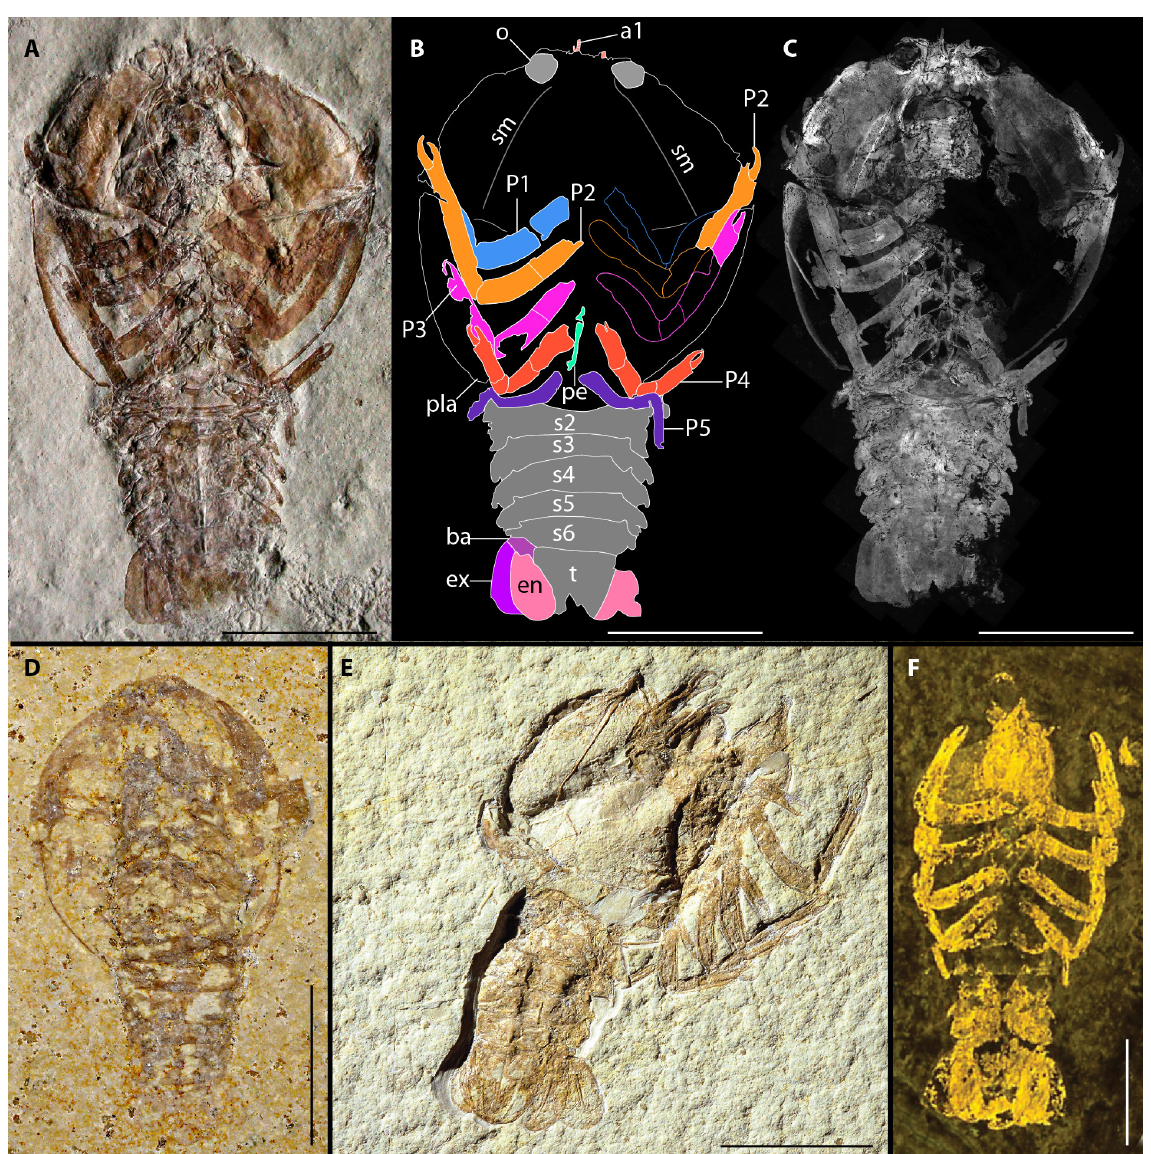
Fig. 5. Rogeryon oppeli (Woodward, 1866) gen. et comb. nov. from the Upper Jurassic (Tithonian) of Germany. A–C . Specimen SMNS 66004 (Sappenfeld), dorsal view, natural light (A), interpretative line- drawing (P1-P3 on one side were restored and are therefore drawn as outline (B) and green fluorescence (C). D . Specimen SMNS 65545 (Eichstätt), ventral view, natural light. E . Specimen SMNS 66004/2 (Langenaltheim), ventral view, natural light. F . Specimen without number (Mörnsheim, K. and H. Schumacher coll.), ventral view, UV light. Abbreviations: a1 = antenna; ba = uropodal basipodite; en = uropodal endopod; ex = uropodal exopod; o = eye; pe = petasma; P1–P5 = pereiopods 1 to 5; pla = posterolateral angle; s1–s6 = pleonites 1 to 6; sm = submarginal carina; t = telson. Scale bars: 20